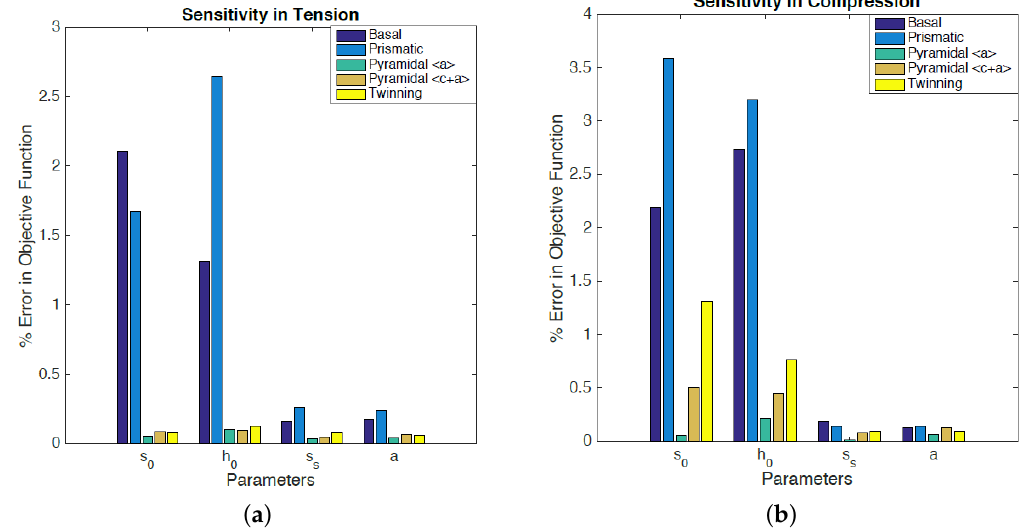
Figure 3. Sensitivity analysis results for optimum design parameters of Ti-0Al. ( a ) Tension results; ( b ) Compression